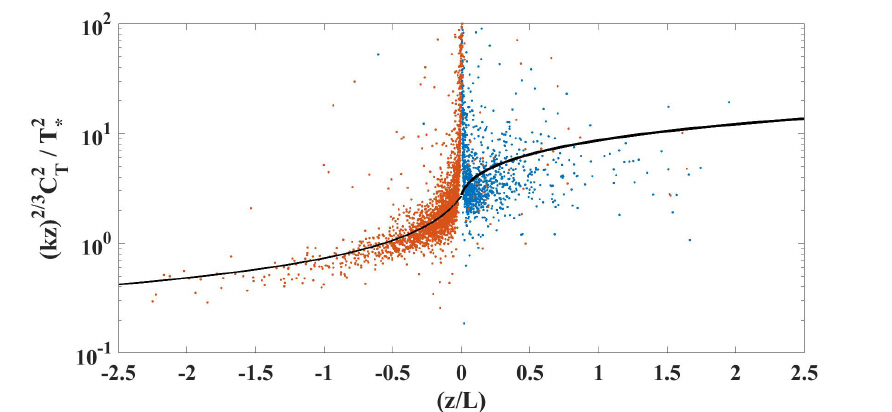
Figure 8. Log( C 2 ) by month from instruments at heights of 6 m and 8 m. T